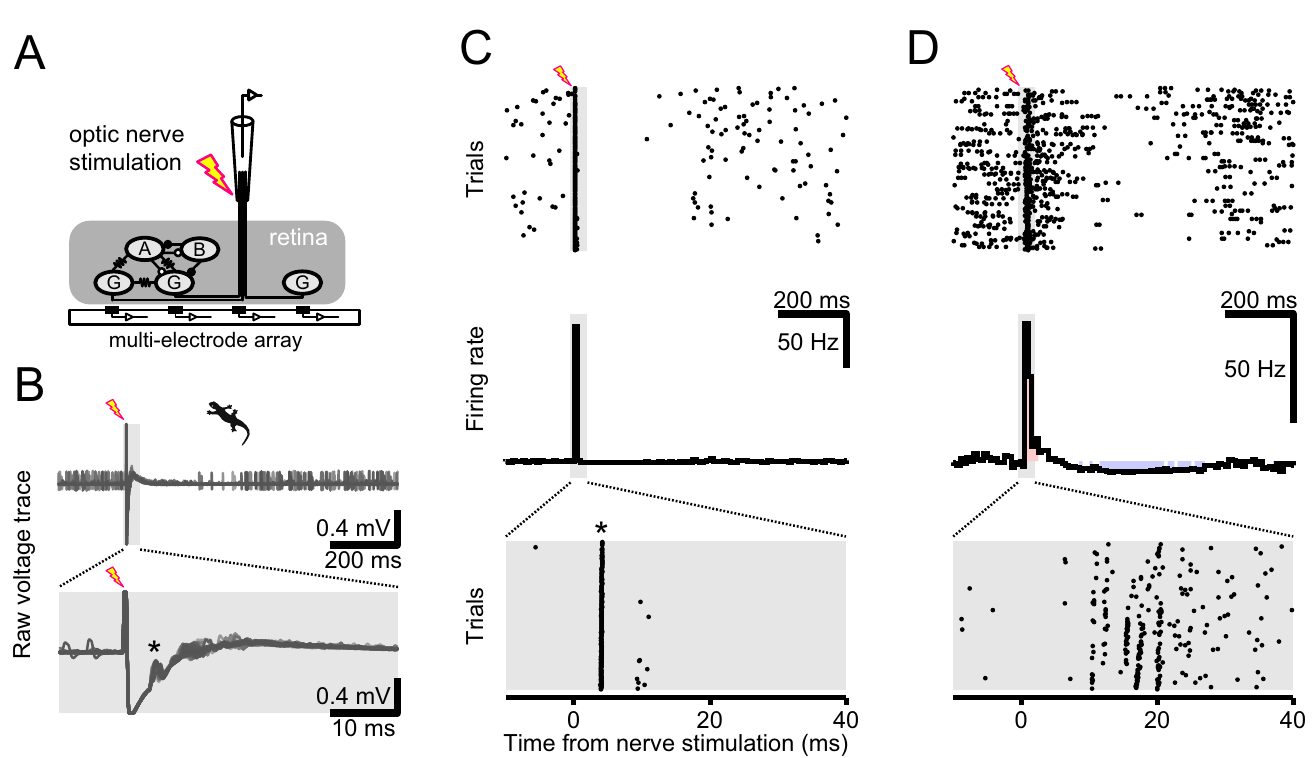
Fig 4. Optic nerve stimulation produces fast excitation and slow inhibition in retinal ganglion cell firing activity. (A) Schematic diagram of the experiment. The tip of the optic nerve emerging from an isolated retina was electrically stimulated with a suction electrode (inter-stimulus interval, 1–1.5 s), while a population of ganglion cells was simultaneously recorded with a multi-electrode array (see panel B for example). A, amacrine cell; B, bipolar cell; G, ganglion cell; open circle, inhibitory synapse; closed circle, excitatory synapse; resistor symbol, electrical synapse. The other retinal cell types and synapses are omitted for simplification. (B) Example raw data traces from an isolated salamander retina overlaid across trials of the optic nerve stimulation in the dark. The lightning symbol indicates the stimulation onset, and the gray area indicates the window for which the magnified traces are shown at the bottom panel. The antidromic spikes are indicated by the asterisk. (C, D) Representative responses of retinal ganglion cells to the optic nerve stimulation (top, raster graphs; bottom, peri-stimulus time histogram (PSTH), magnified at the bottom for the window indicated by the gray area). A period of suppression was observed in cells either with (C) or without (D) antidromically evoked spikes (asterisk). Red- and blue-shaded bins in the PSTHs indicate those in which the firing rate significantly increased or decreased from the spontaneous activity, respectively (significance level of 0.05 without correction by the number of time bins).